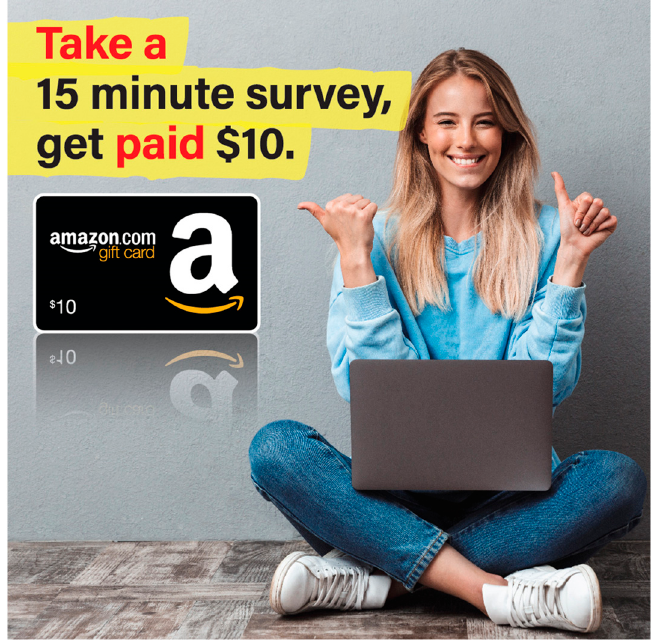
Figure 4. Facebook study recruitment ad.